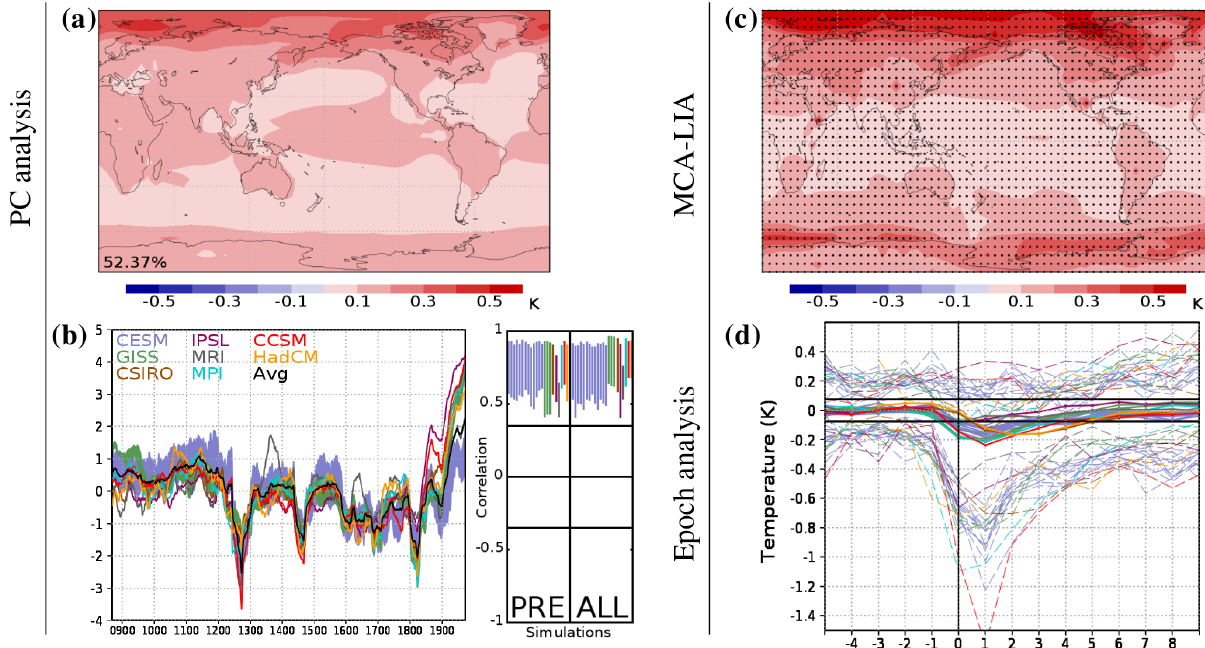
Figure 2. Analysis of temperature for the ensemble of simulations included in Table 1. (a) First EOF and (b) first PC time series for each simulation, as well as the average PC of all the simulations (black line). The percentage of explained variance is shown within the EOF map. The range of correlations between the PC of each simulation and those of other simulations is also included on the right of the plotted PCs both for the whole period (ALL) and for the preindustrial era (PRE). For these correlations, the significance level ( p < 0 . 05) accounting for autocorrelation is shown with a black line. (c) Map of temperature differences between MCA and LIA. Dots indicate locations where the differences are significant ( p < 0 . 05). (d) Composite average (solid lines) and maximum and minimum (dashed lines) global temperature anomalies in the 5 years before and 10 years after the 12 main volcanic eruptions of the LM. The vertical line indicates the year of the volcanic event. The horizontal black lines show the significance level of the average ( p < 0 . 10) based on the distribution of averages of 12 years generated with 2200 sets randomly taken from the whole period excluding the years of the 12 main volcanic eruptions and the 10 years after them.